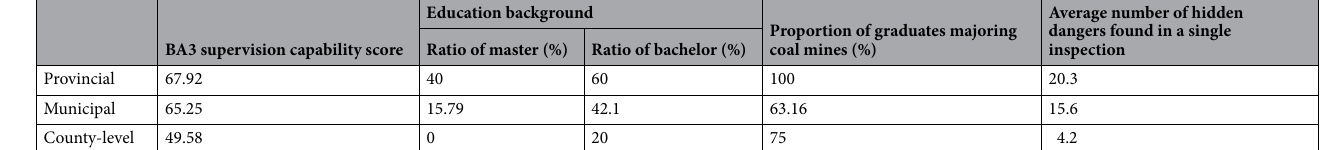
Table 12. Comparison of the supervision effect score of provincial, municipal, and county-level supervision departments (subsystem B) and the basic information of supervisors.